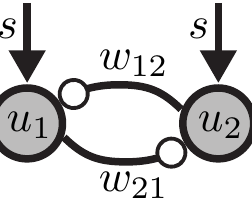
Figure 11: Connectivity diagram for two dynamic neurons with mu- tual inhibition receiving the same stimulus (Equation